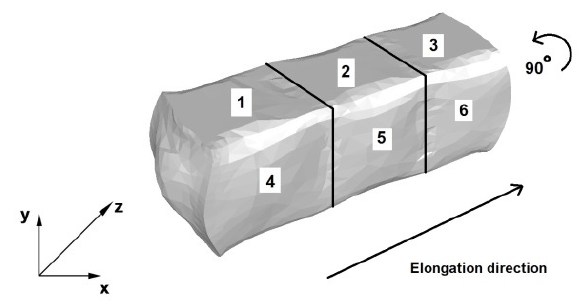
Figure 5. Flat die elongation process diagram [15].